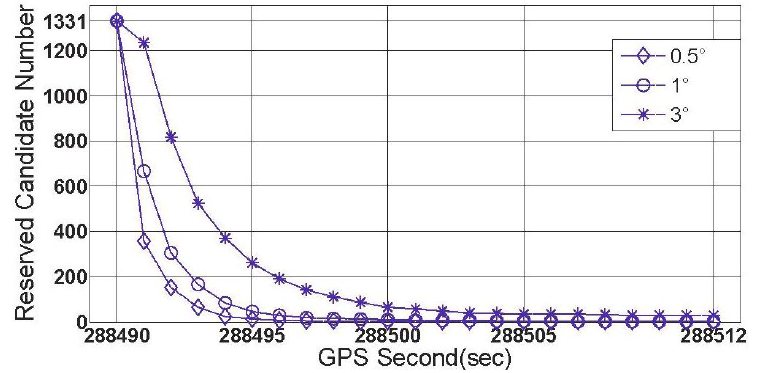
Figure 11. The first group of results of feasibility test (data section